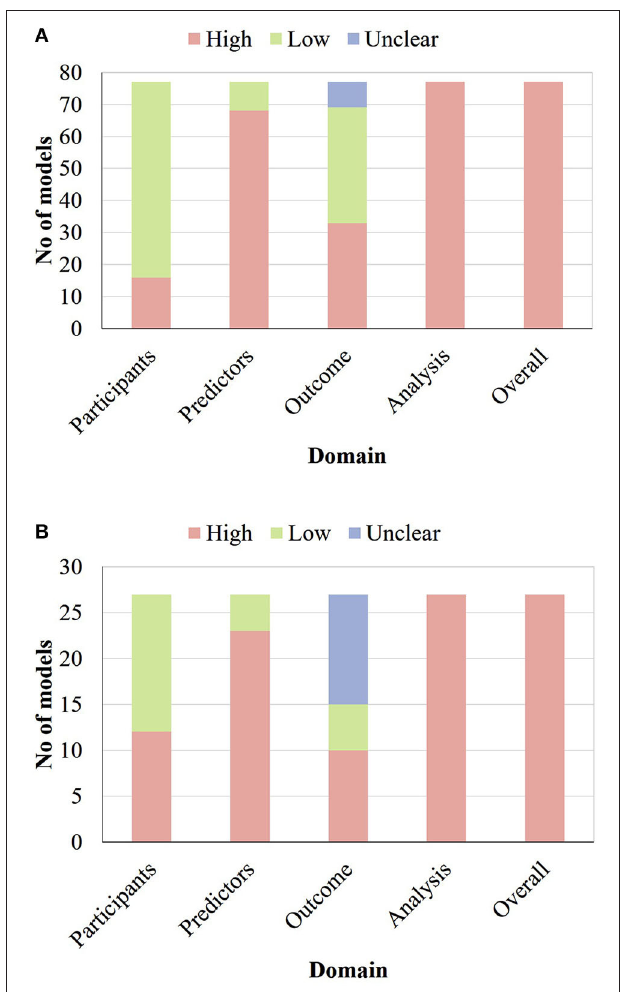
FIGURE 3 | Risk of bias assessment (using PROBAST) based on four domains across 77 prognostic model development studies related to cervical cancer (A) and across 27 external validation efforts of prognostic models related to cervical cancer (B)